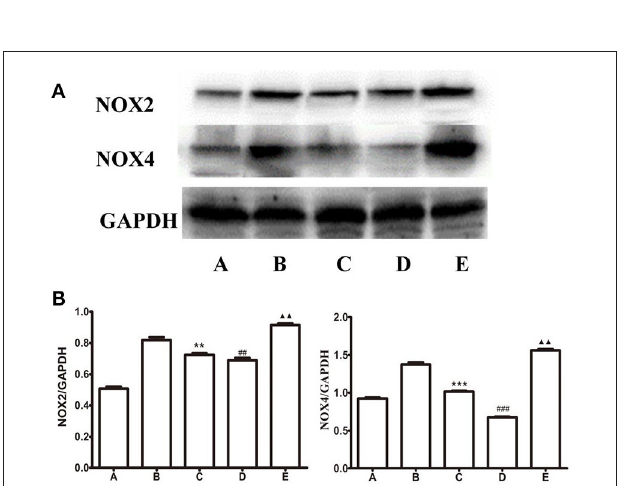
FIGURE 10 | Expression of NOX2 and NOX4 in the gastric mucosa. (A) Western blots of IL-1 β in the gastric mucosa. (B) Quantitative analysis of IL-1 β in the gastric mucosa. GAPDH was used as a loading control. n = 5, ** P < 0.01 (*** P < 0.001), as compared with the GI-R group; ## P < 0.01 ( ### P < 0.001), as compared with the GI-R group; NN P < 0.01, as compared with the GI-R group. A, Normal group; B, GI-R group; C, FN + GI-R + L -Glu group; D, LHA + GI-R + Baclofen group; E, LHA + GI-R + CGP35348 group.